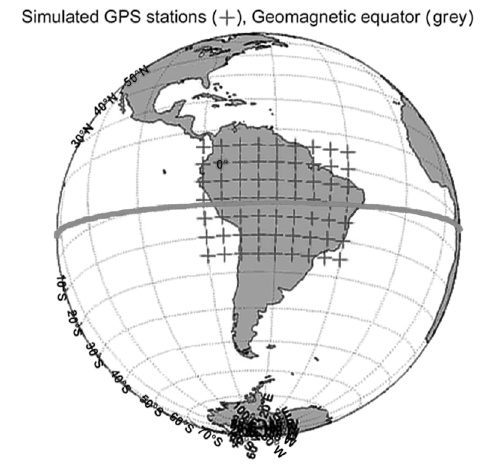
Fig. 1. The network of 56 virtual ground GPS re- ceivers used in the present study. The grey curve rep- resents the geomagnetic